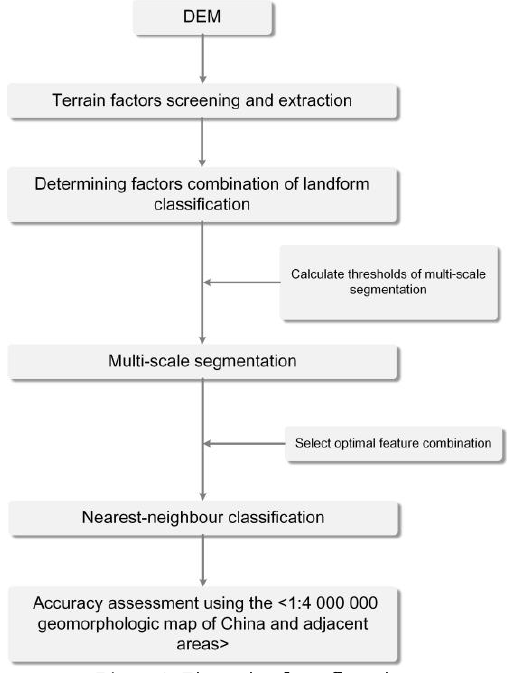
Figure 3. The technology flow chart